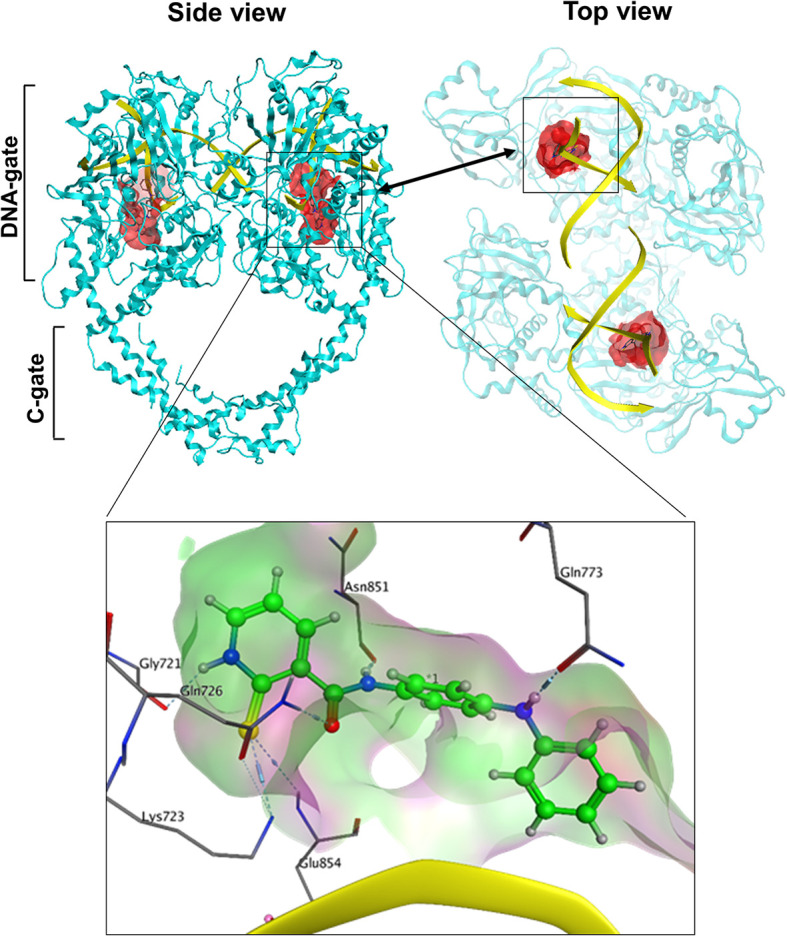
The spatial relationship of the docking pocket with TOP2 and DNA. Both top and side views show the relative position of TOP2A dimer (cyan), DNA substrate (yellow), and the molecular surface of the docking pocket (red) used for in silico drug screening.